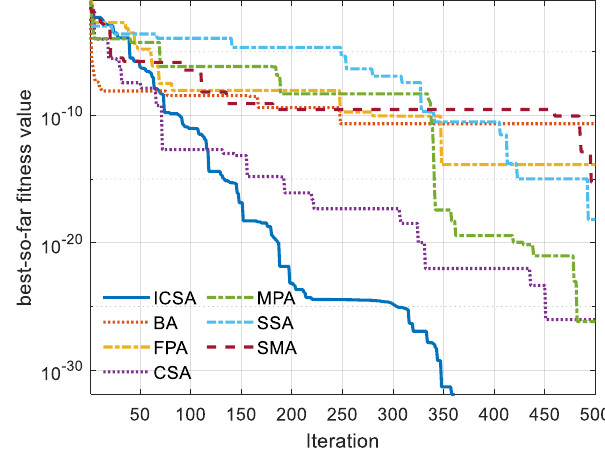
Figure 8. Convergence curve for F8.